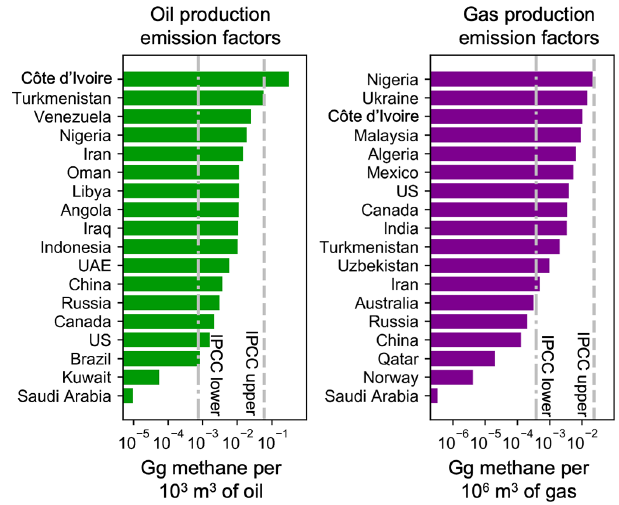
Figure 3. Methane emission factors for oil–gas production activ- ities in 2019. Emission factors are shown for the top methane- emitting and oil–gas-producing countries and for the IPCC Tier 1 methods (2006). Country emission factors are determined using GFEI v2 oil–gas production emissions and EIA oil–gas production statistics. The IPCC emission factors show the sum of all emission processes (leakage, venting, flaring) with the lower emission factor reflecting the lowest range provided for developed countries and the upper emission factor reflecting the highest range provided for de- veloping countries and countries with economies in transition. For oil production, we show emission factors for conventional oil pro- duction. US – United States; UAE – United Arab Emirates.